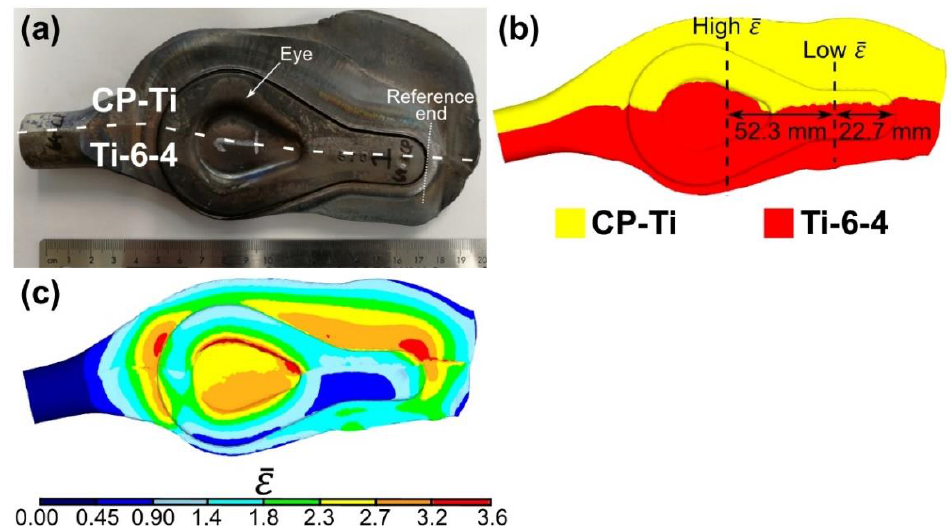
Figure 10. ( a ) Photograph of the Ti-6-4 with CP-Ti near-net shape forging, eye-bolt 1; ( b ) corresponding FE model showing the alloy distribution; and ( c ) the corresponding FE model showing the effective strain distribution. Approximate forging temperature between 860 and 878 °C, with a total of nine hammer steps.